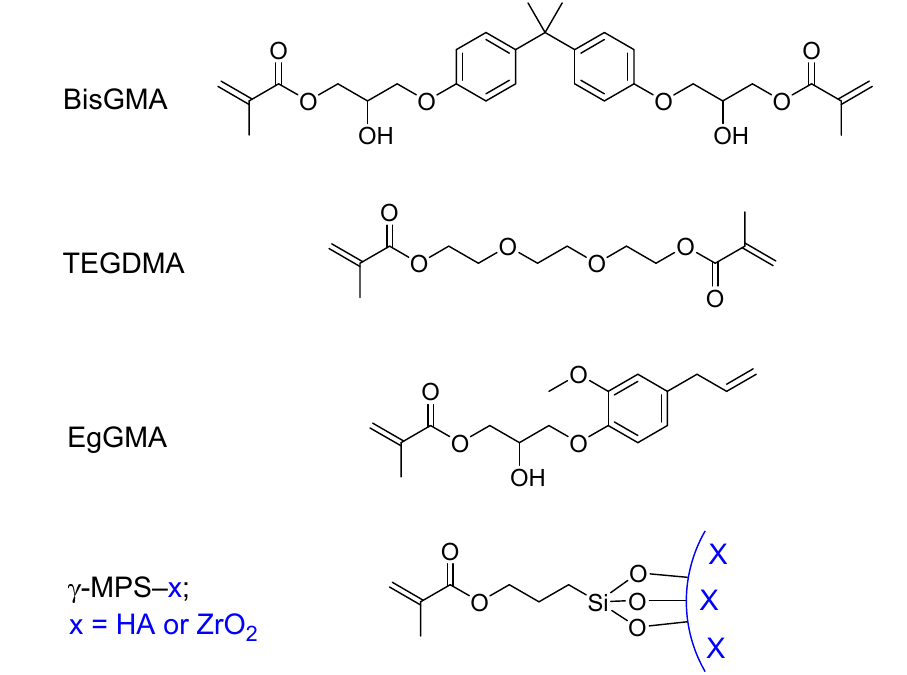
Figure 1. The chemical structure of BisGMA, TEGDMA, EgGMA and silanized particles.